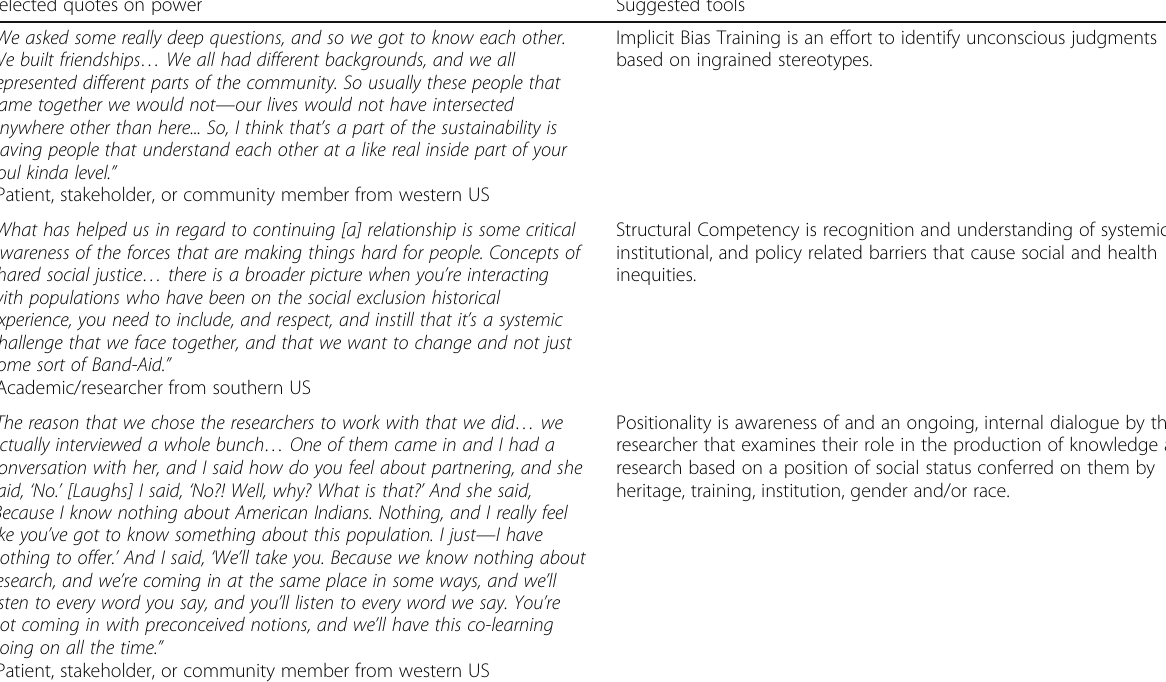
Table 3 Selected interview quotes on power dynamics and corresponding tools to address power differentials Selected quotes on